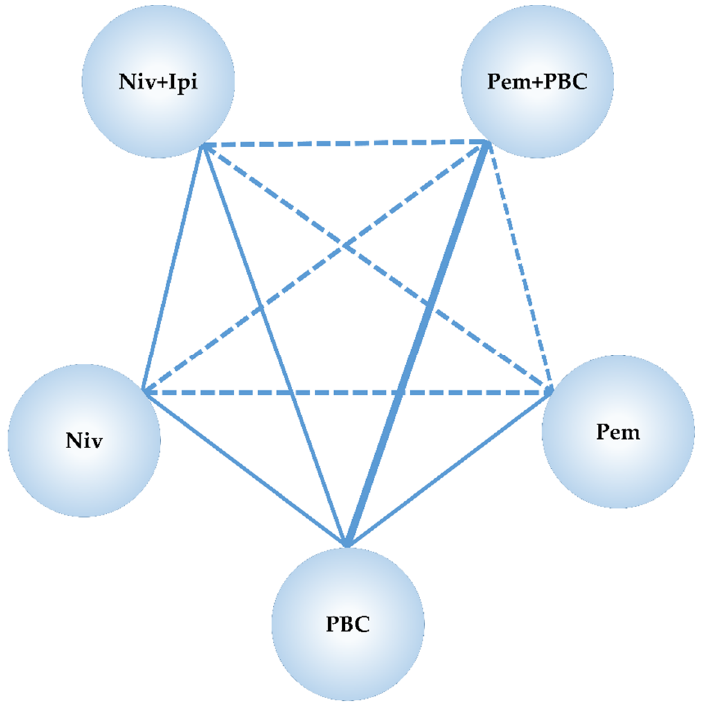
Figure 2. Network map of the network meta-analysis performed in this study. The randomized controlled trials (RCTs) included in this analysis are represented by solid lines, and the thickness of solid line indicates the number of included studies. The dashed line indicates a relationship where no RCT exists but an indirect comparison could be attempted. s.c., subcutaneous; RCT, randomized controlled trial; Niv, nivolumab; Ipi, ipilimumab; Pem, pembrolizumab; PBC, platinum-based chemotherapy.